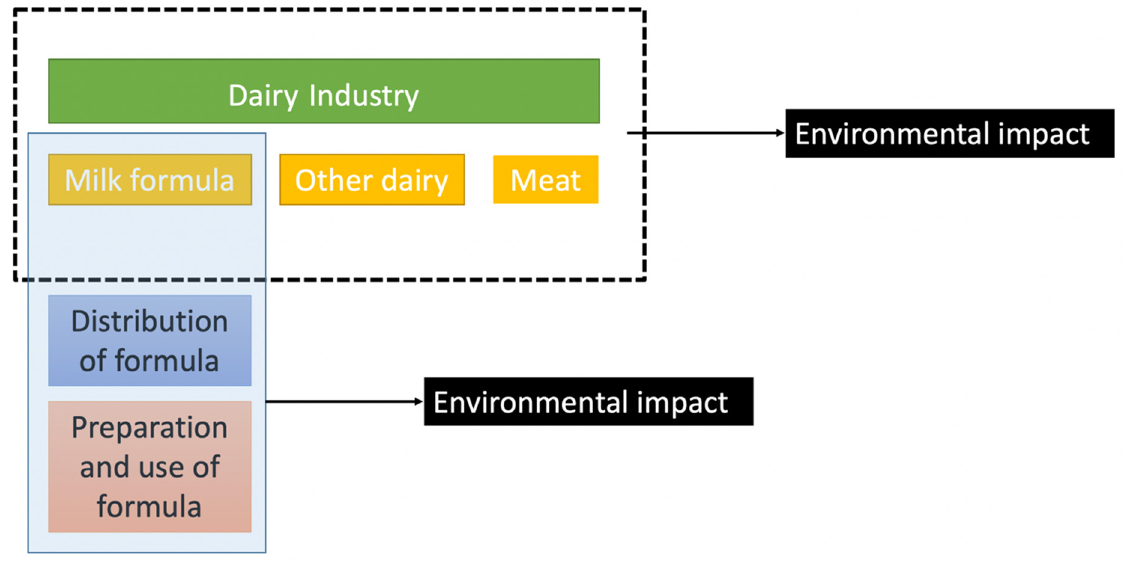
Figure 1. A framework for understanding the environmental impacts of formula use and the dairy industry and their interconnections.